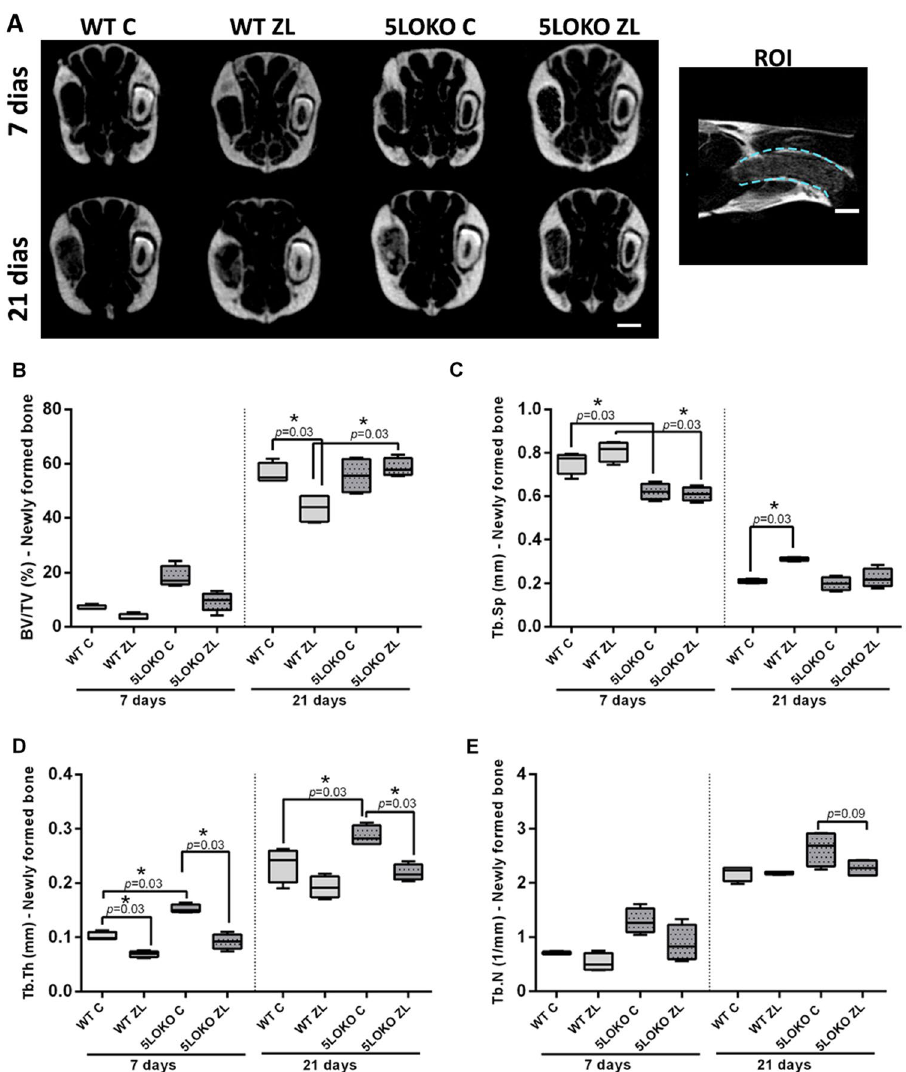
Figure 2. MicroCT analysis of alveolar sockets post tooth extraction from WT vs. 5LOKO mice treated or not with ZL. Aged 129 Sv WT and 5LOKO female mice received IP injections of 0.9% saline solution (C) or 250 μg/Kg (ZL groups) once a week, and upper right incisor were extracted at 4 week of each treatment. Mice were euthanized for maxillary bones removal after 7 days and 21 days post tooth extraction. ( A ) Representative transaxial images of bone hyperdensity. Scale bar 1.5 mm. ( B ) Bone volume/Tissue Volume (BV/TV, %), ( C ) Trabecular Separation (Tb.Sp), ( D ) Trabecular Thickness (Tb.Th), and ( E ) Trabecular Number (Tb.N) for new bone in alveolar sockets and 7 and 21 days post tooth extraction. Quantitative results are presented with Box and whiskers (Min to Max). Symbol * indicates a statistically significant differences between different treatments and/or genotypes (p <